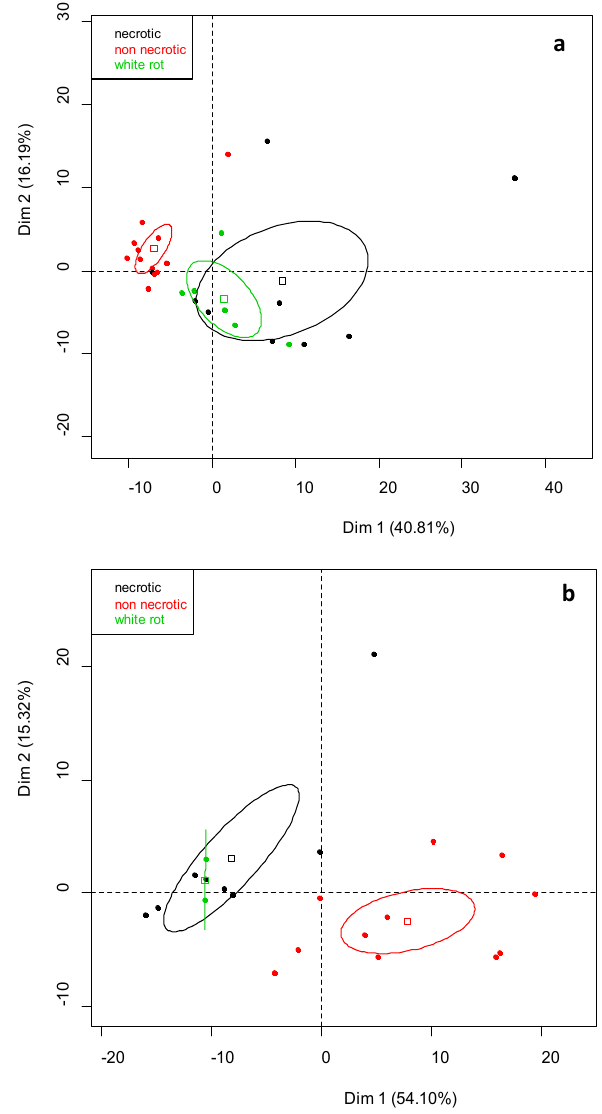
Figure 4. Principal component analysis (PCA) of fungal (a) and bacterial (b) communities colonizing the non-ne- crotic and necrotic tissues of cordons or trunks of esca-fo- liar symptomatic or asymptomatic 30-year-old grapevines, based on SSCP profiles. The variation (%) explained by each PCA axis is given in parentheses. PCA eigenvalues indicate that the first two components, Dim 1 and Dim 2, account for a percentage of the total bacterial variability. Squares cor- respond to individual SSCPs and ellipses to the 95% confi - dence intervals calculated for each